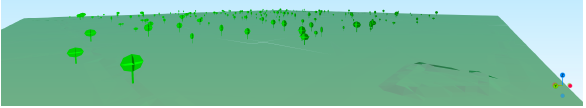
Figure 12. Sample of ImplicitGeometry Trees in Rijssen-Holten testbed. The location of each tree is extracted from the data-